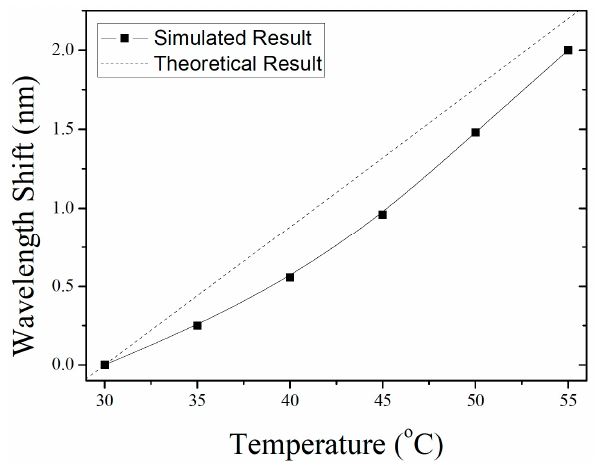
Figure 7. Simulation of temperature sensitivity of sensor: Wavelength shift versus temperature.